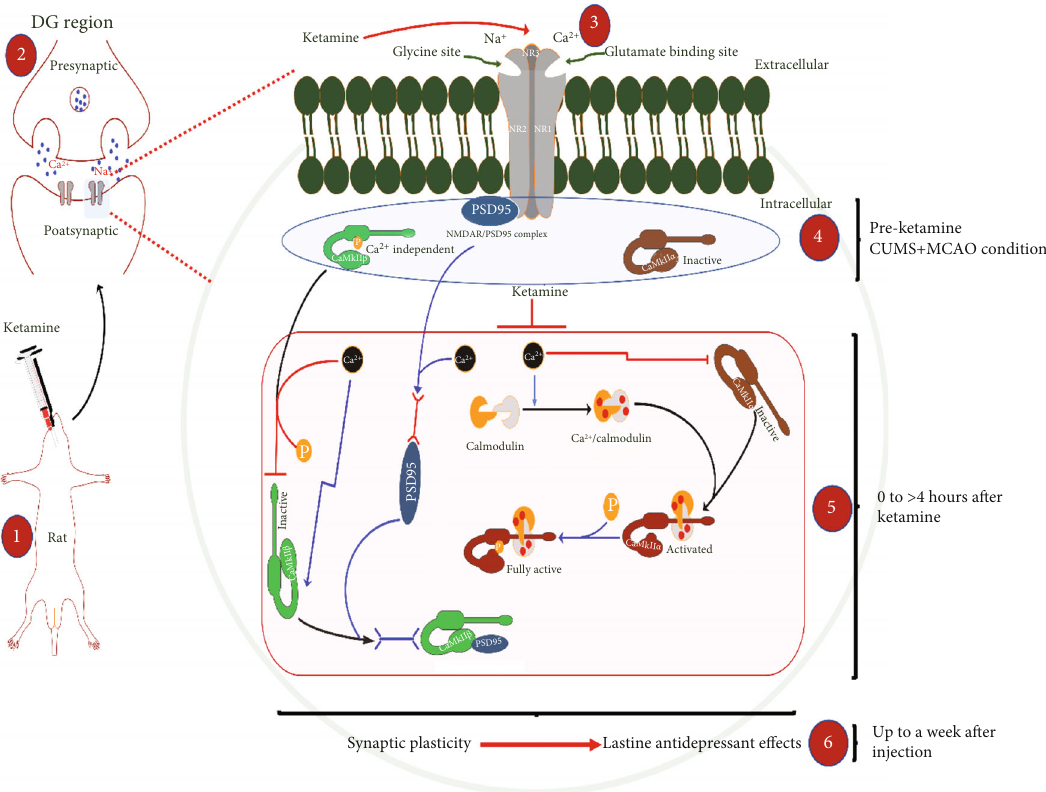
Figure 6: Ketamine-mediated lasting antidepressant e ff ects result from NMDAR/CaMKII induced synaptic plasticity. A proposed model for the rapid and lasting actions of ketamine through the NMDAR/CaMKII pathway is presented. Administration of ketamine regulates calcium in fl ux through its action on NMDAR resulting in rapid inhibition of CaMK2B phosphorylation and transcriptional stimulation of its inactive form. At the same time, ketamine promotes the dissociation of PSD95 from the NR2B/PSD95 complex in favor of newly formed CaMK2B/PSD95 complexes, leading to a signi fi cant stimulation of synaptic plasticity. In parallel, ketamine ’ s regulation of intracellular calcium levels also leads to rapid phosphorylation of CaMK2A, further supporting the plasticity process through stimulation of plasticity- related proteins (PSD95). Overall, the results suggest that ketamine ’ s temporary regulation of the NMDAR/CaMKII pathway not only accounts for its rapid actions but also initiates profound and lasting changes ( < a week) at the postsynaptic level leading to its lasting antidepressant e ff ects. The illustration was partially based on motifs from